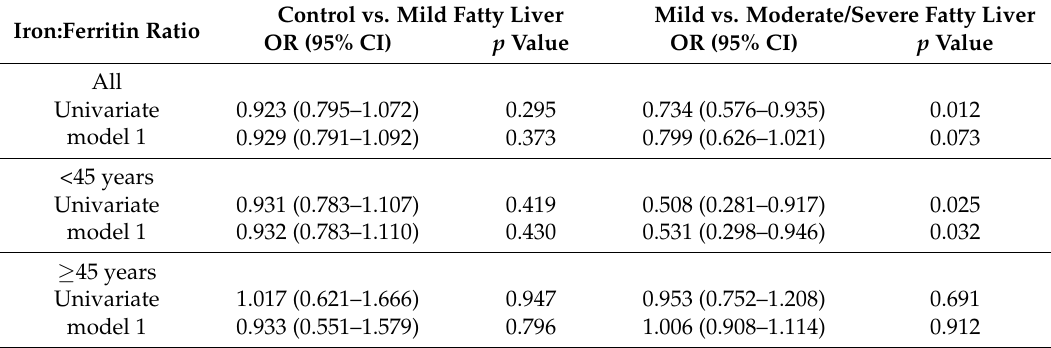
Table 2. Age ‐ adjusted odds ratios (OR) and 95% confidence intervals (CIs) for fatty liver severity. Control vs. Mild Fatty Liver Iron:Ferritin Ratio